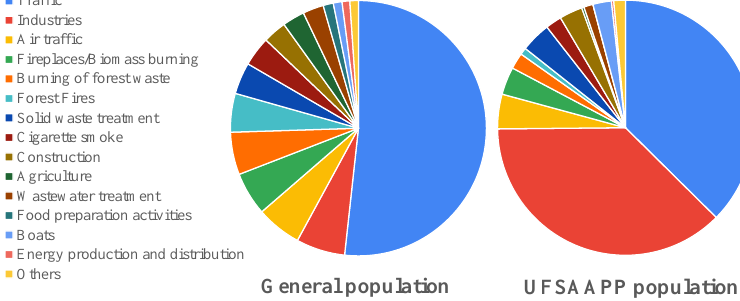
Figure 5. Air pollution sources identified by the general and the UFSAAPP populations. For the general population, traffic was the most frequently identified pollution source, being referred by 51.7% of the respondents in the general population, which agrees with other studies where traffic was highlighted as one of the main sources of air pollu- tion: China (with 78.5%) [19] , Malaysia (where “motor vehicle emissions” were ranked as